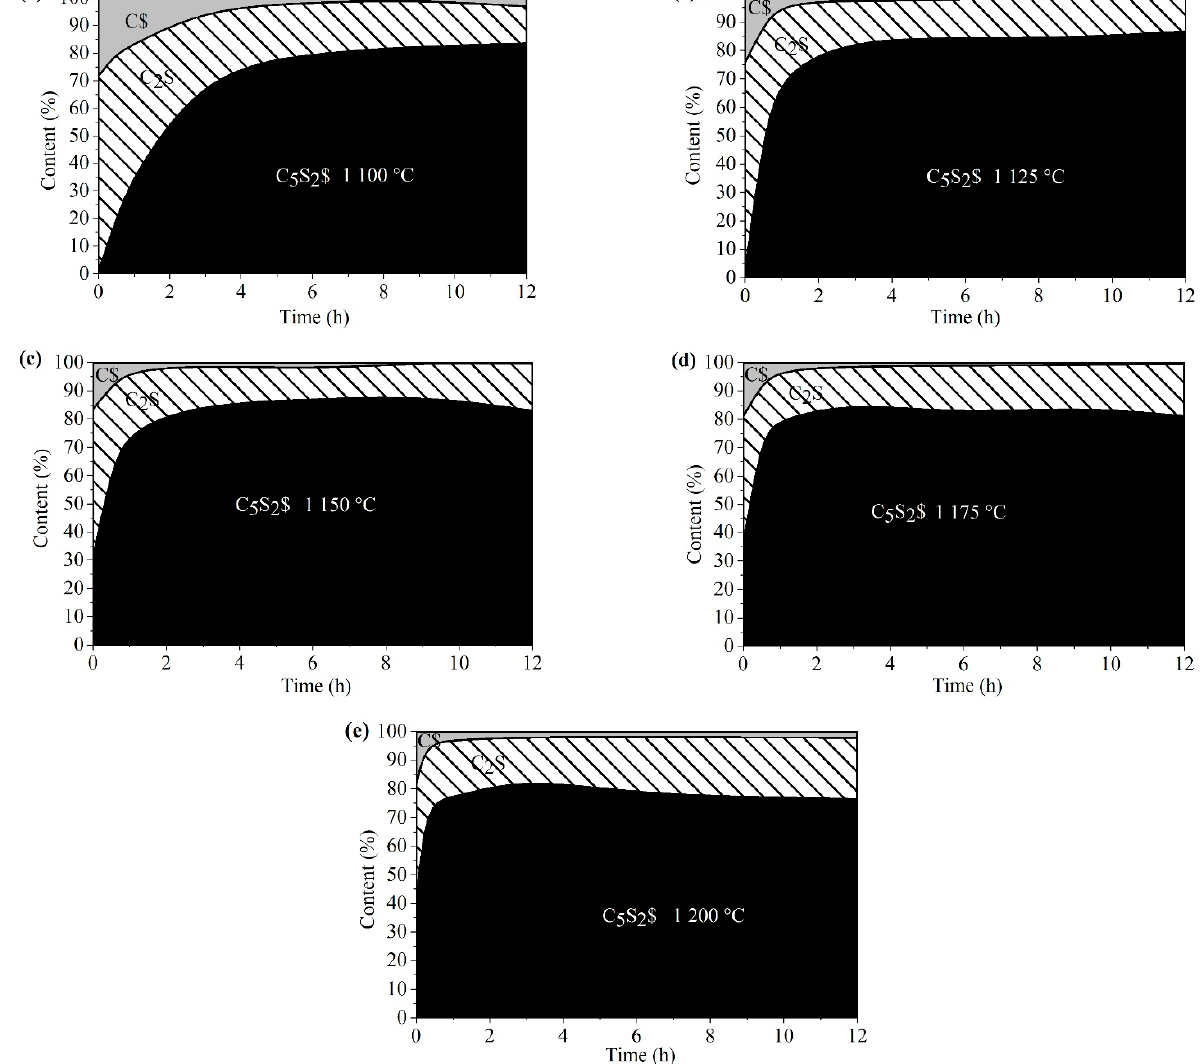
Figure 8. Area plot of the phase composition for the sintering of the raw mixtures of beta-C 2 S and ◦ C ( a ), 1125 ◦ C ( b ), 1150 ◦ C ( c ), 1175 ◦ C ( d ), and 1200 ◦ C ( e ) with calcining CaSO 4 ∙ 2H 2 O at 1100 °C ( a ), 1125 °C ( b ), 1150 °C ( c ), 1175 °C ( d ), and 1200 °C ( e ) with calcining time. CaSO · 2H 4 2 O at 1100